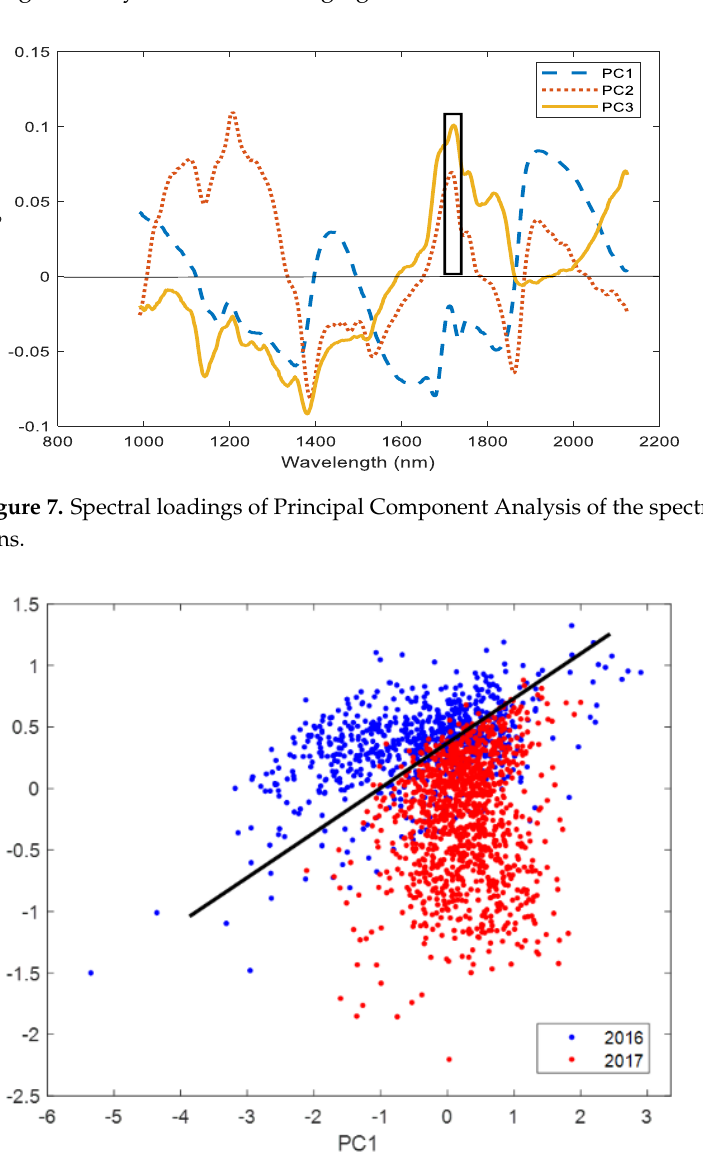
Figure 8. PCA score plot of the first two PCs categorized by season with a segregation line be- tween seasons 2016 and 2017 in both PCA. seasons 2016 and 2017 in both